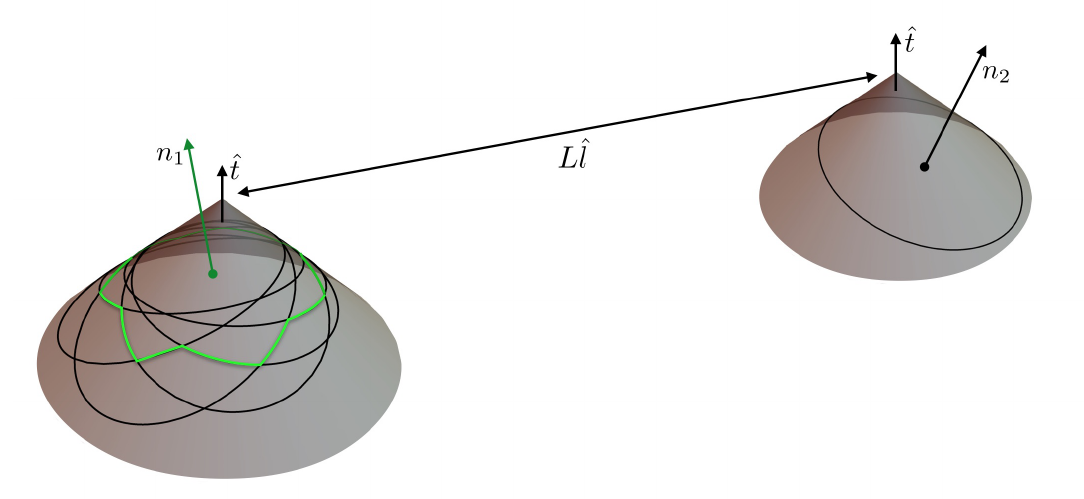
Figure 3 . Geometric setup of multiple boosted and rotated spheres used to derive